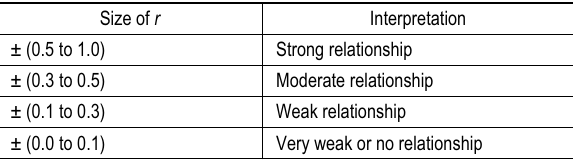
Table 6. Strength of the relationships Size of r Interpretation